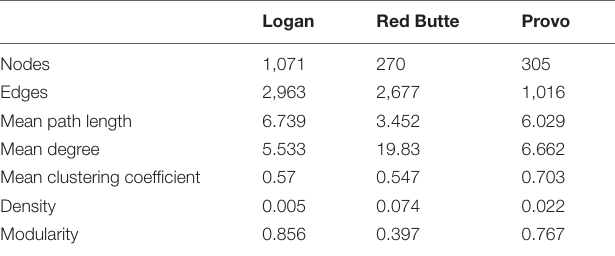
Nodes indicate taxa (OTUs) and edges connect where significant co-occurrence was detected in 75% of samples, edges represent significant co-occurrence connections that occur in at least 75% of samples in each watershed and have an MIC that is both > 0.7 and statistically significant. Mean path length: the average number of steps to connect each node; Mean degree: average number of edges for each node; Mean clustering coefficient: a measure of how completely neighboring nodes are connected to each